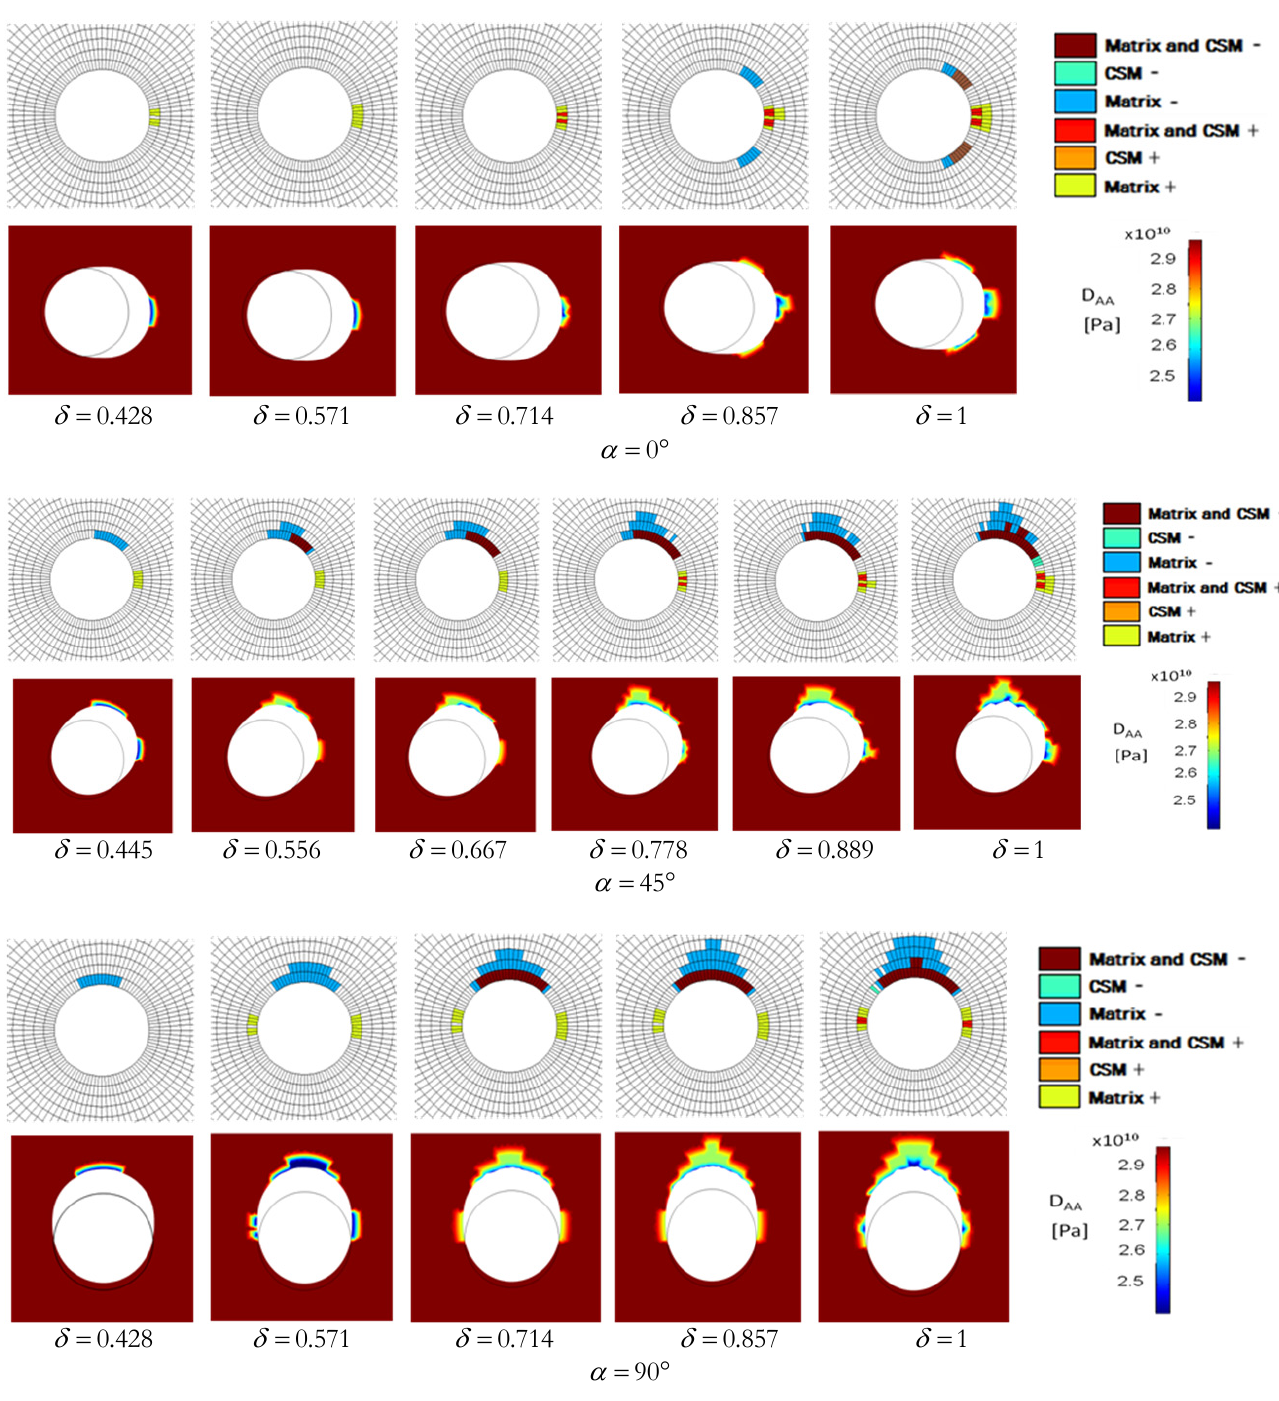
u u  , max AA denotes the